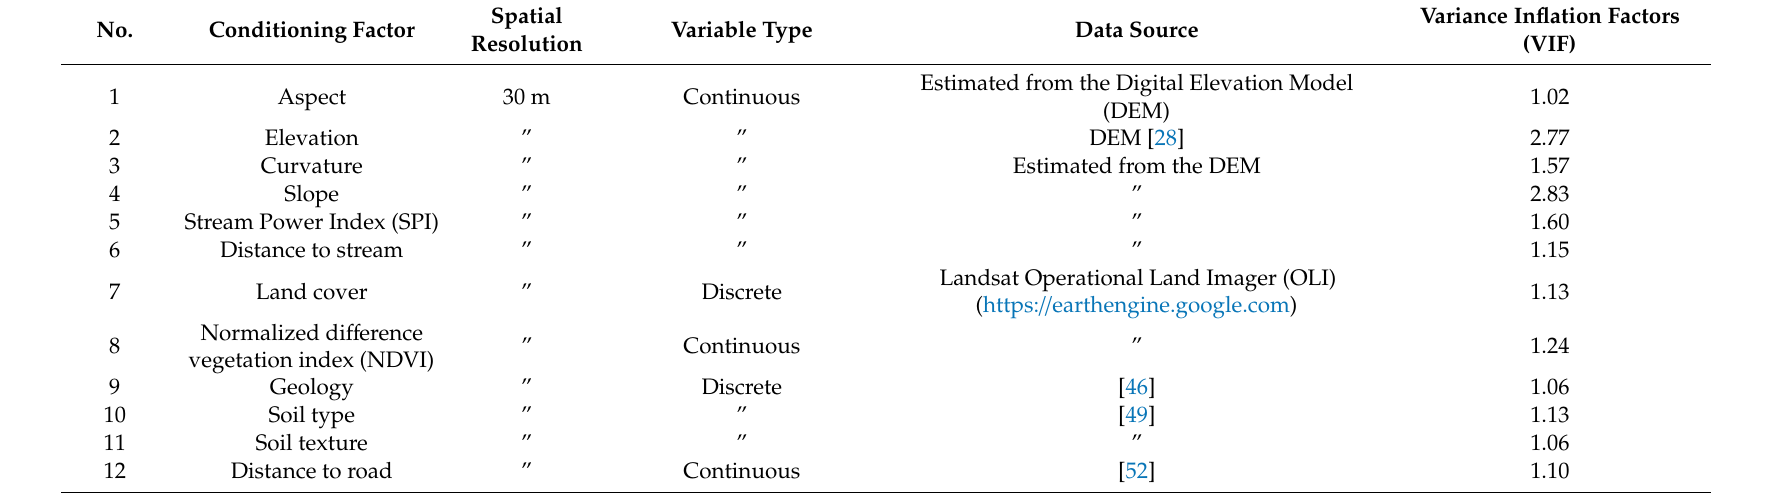
Table 1. Landslide conditioning factors used in this